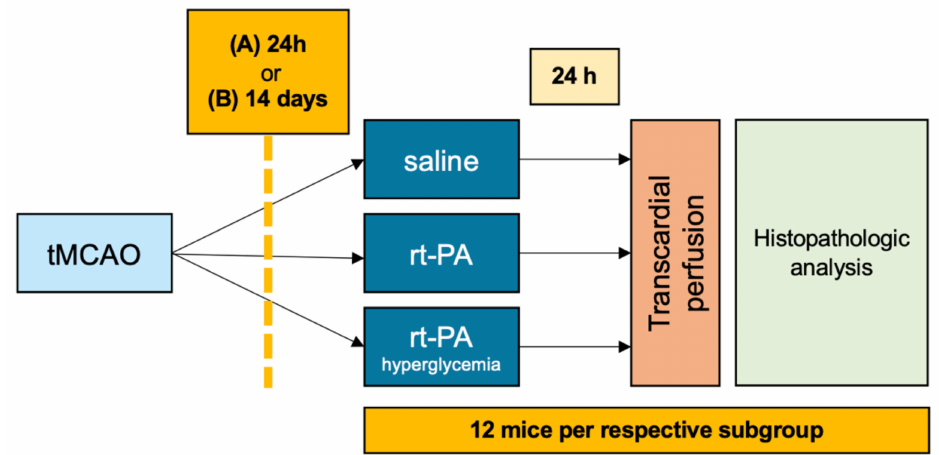
Figure 1. Timeline diagram of the experimental procedures . Hyperglycemia was induced by streptozotocin (STZ) injection 4 weeks prior to ischemic stroke. Experimental stroke was induced with transient middle cerebral artery occlusion (tMCAO) for 30 min. Saline, as control, or recombinant tissue plasminogen activator (rt-PA) was administered (A) 24 h or (B) 14 days after